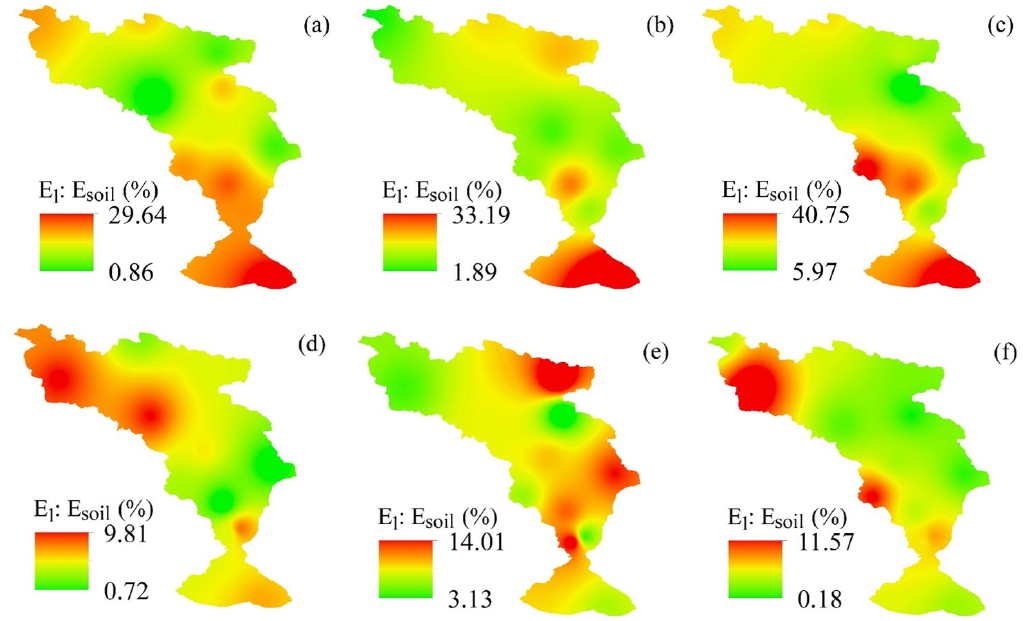
Figure 8. Spatial variation of the proportion of soil fractionation in soil evaporation ( E 1 : E soil ) in summer 2018 ( a – c ) and 2019 ( d – f ).